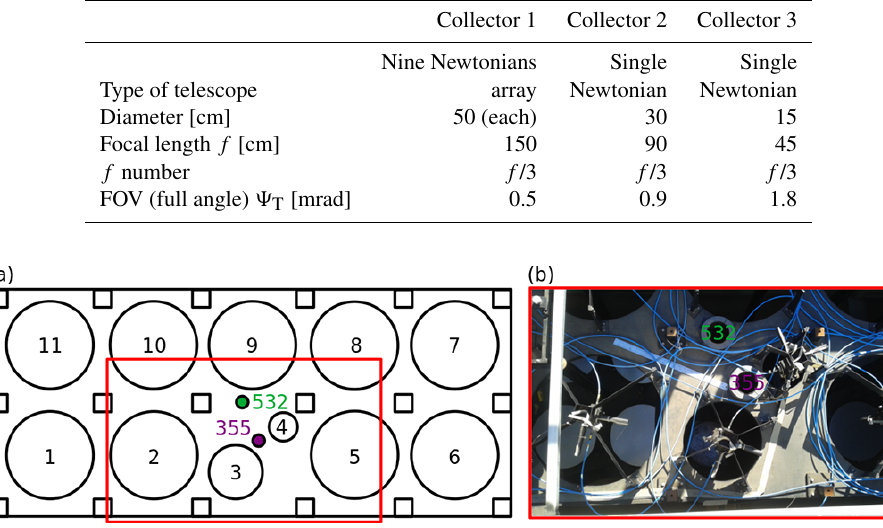
Figure 2. (a) Top view schematic of the relative position of the laser beams (355 and 532) and the 11 telescopes. (b) Details of the emission and low-range telescopes (15 and 30cm).